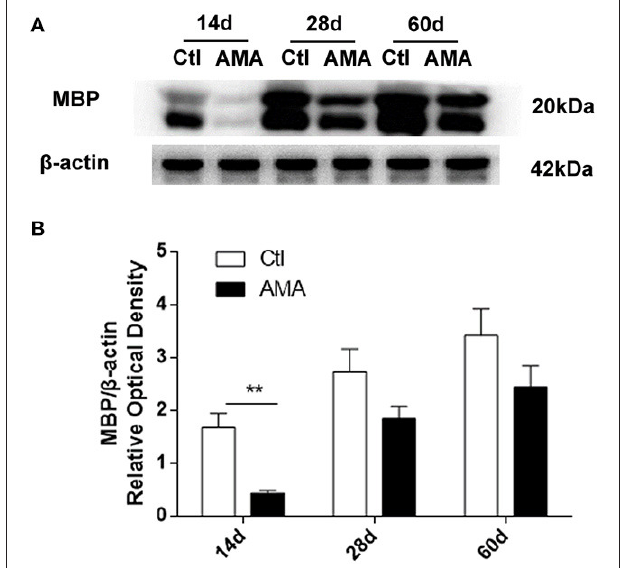
FIGURE 3 | Effects of AMA on MBP protein expression levels in the hippocampus in different groups. (A) Representative protein bands of MBP in hippocampal tissue samples collected from rats on P14, P28, and P60. (B) Quantitative analyses of the MBP/ β -actin expression level at different times for each group. Values are the mean ± SEM ( n = 6 rats in each group), ** p <